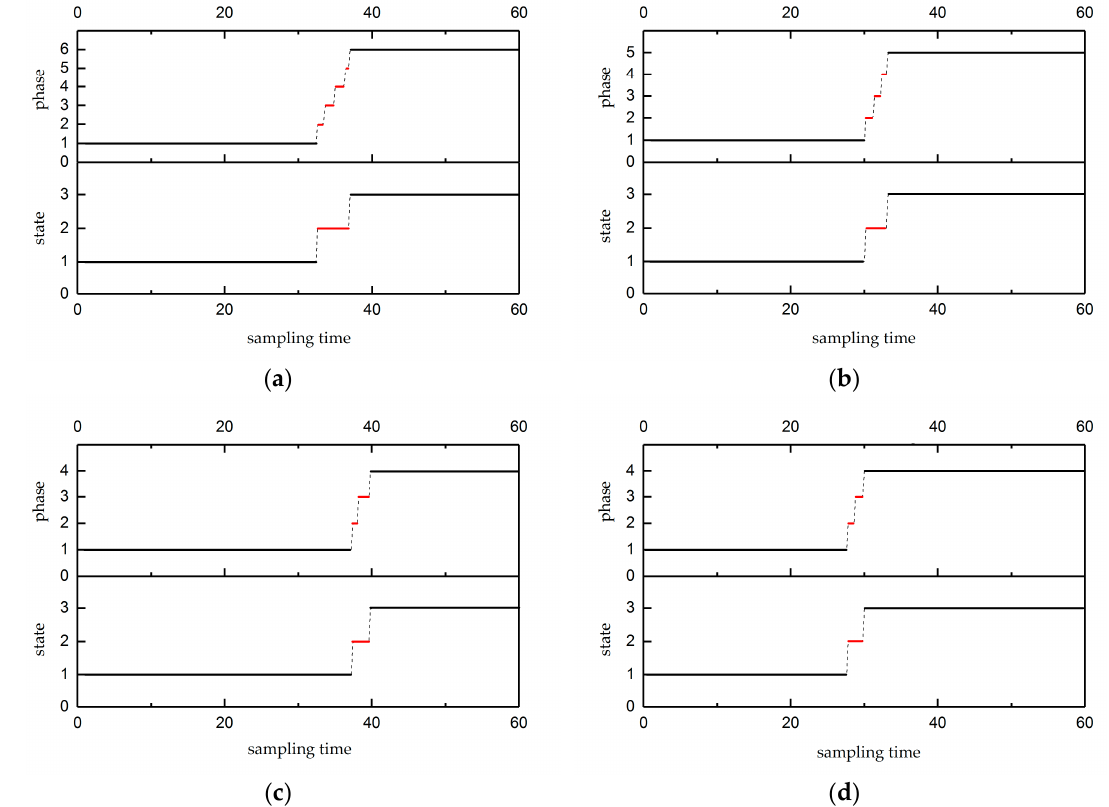
Figure 8. State divided and transition state identification results: ( a ) thickness = 1.5 mm, upper pressure = 40 Pa; ( b ) thickness = 1.5 mm, upper pressure = 90 Pa; ( c ) thickness = 2 mm, upper pressure = 40 Pa; and ( d ) thickness = 2 mm, upper pressure = 90 Pa.